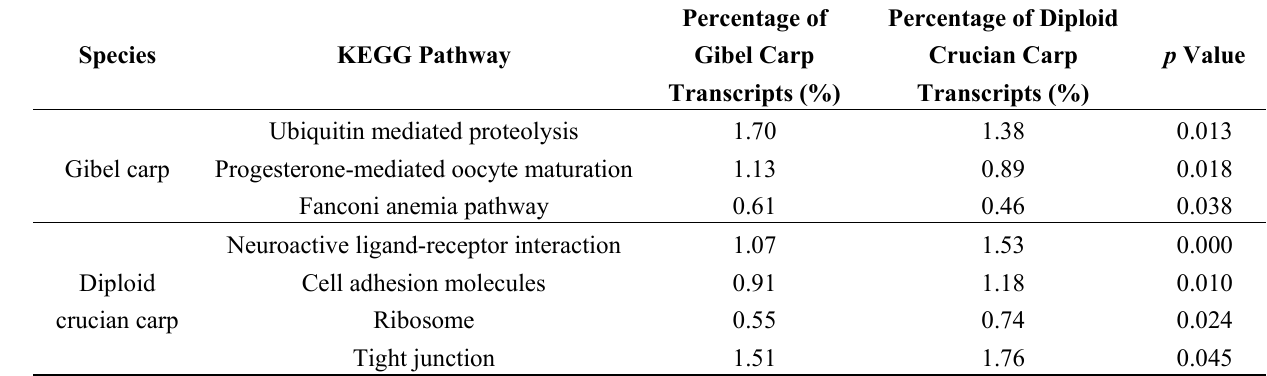
Table 3. The enriched pathways in gibel carp and diploid crucian carp identified by KOBAS ( p value <